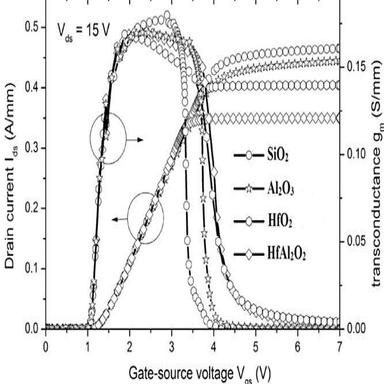
Showing transfer (Ids-Vgs) curve and the device transconductance gm of which the drain voltage (Vds) was measured from 0 V to 15 V with SiO2, Al2O3, HfO2 and HfAl2O2.